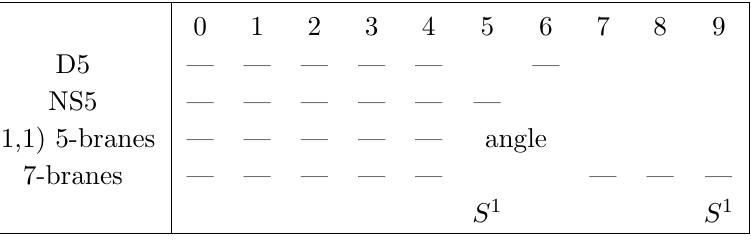
Table 2 . Brane setup when one compacti(cid:12)es the x 8